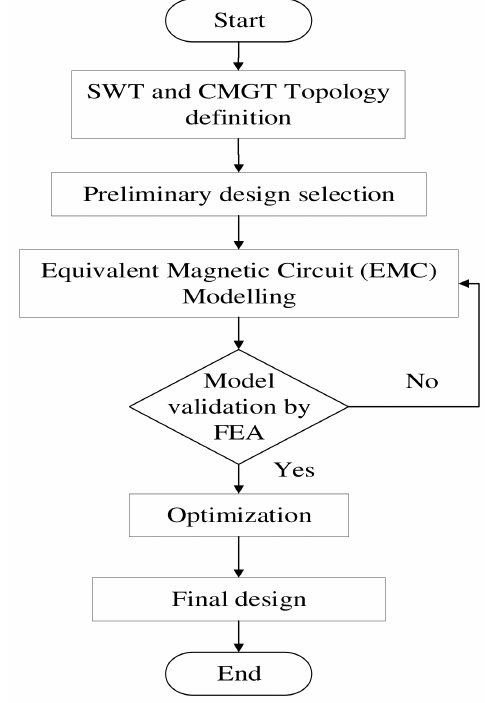
Figure 2. Design process of CMGT used for SWT.